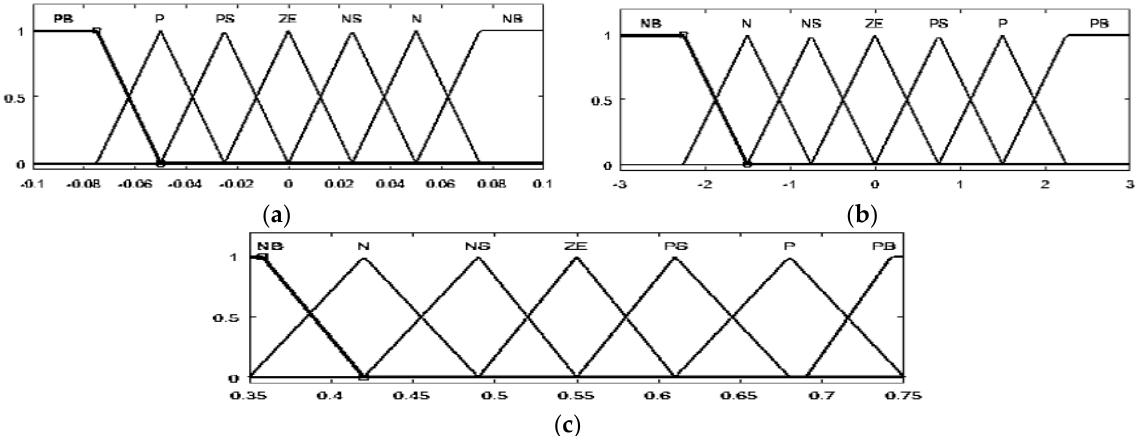
Figure 6. The membership function of E ( a ), dE ( b ) and duty cycle ( c ) of the high-gain DC-DC converter.